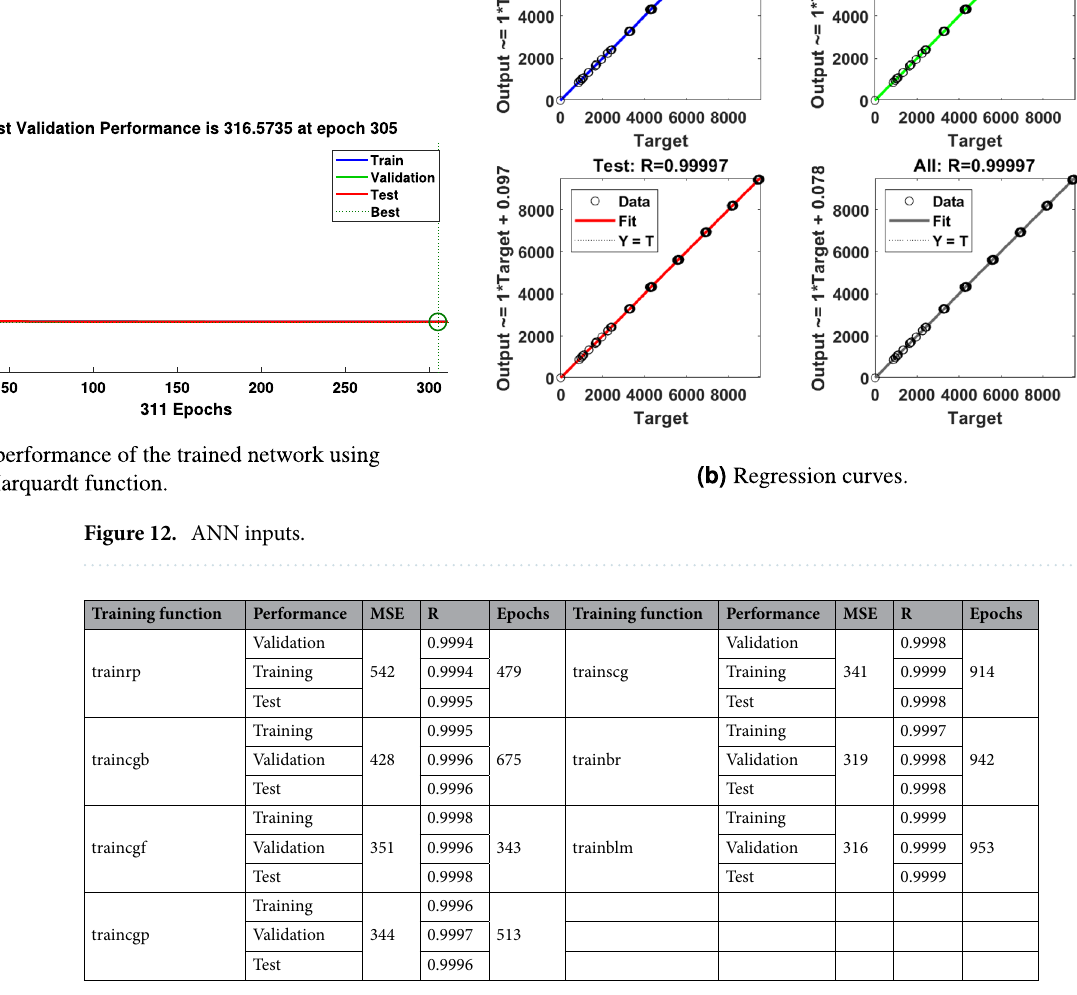
Table 4. History of training performance employing varied training